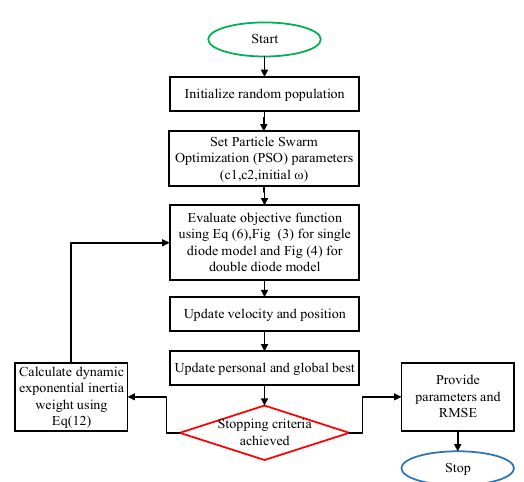
Figure 5. Flow chart of the proposed methodology for estimating photovoltaic (PV) parameters.